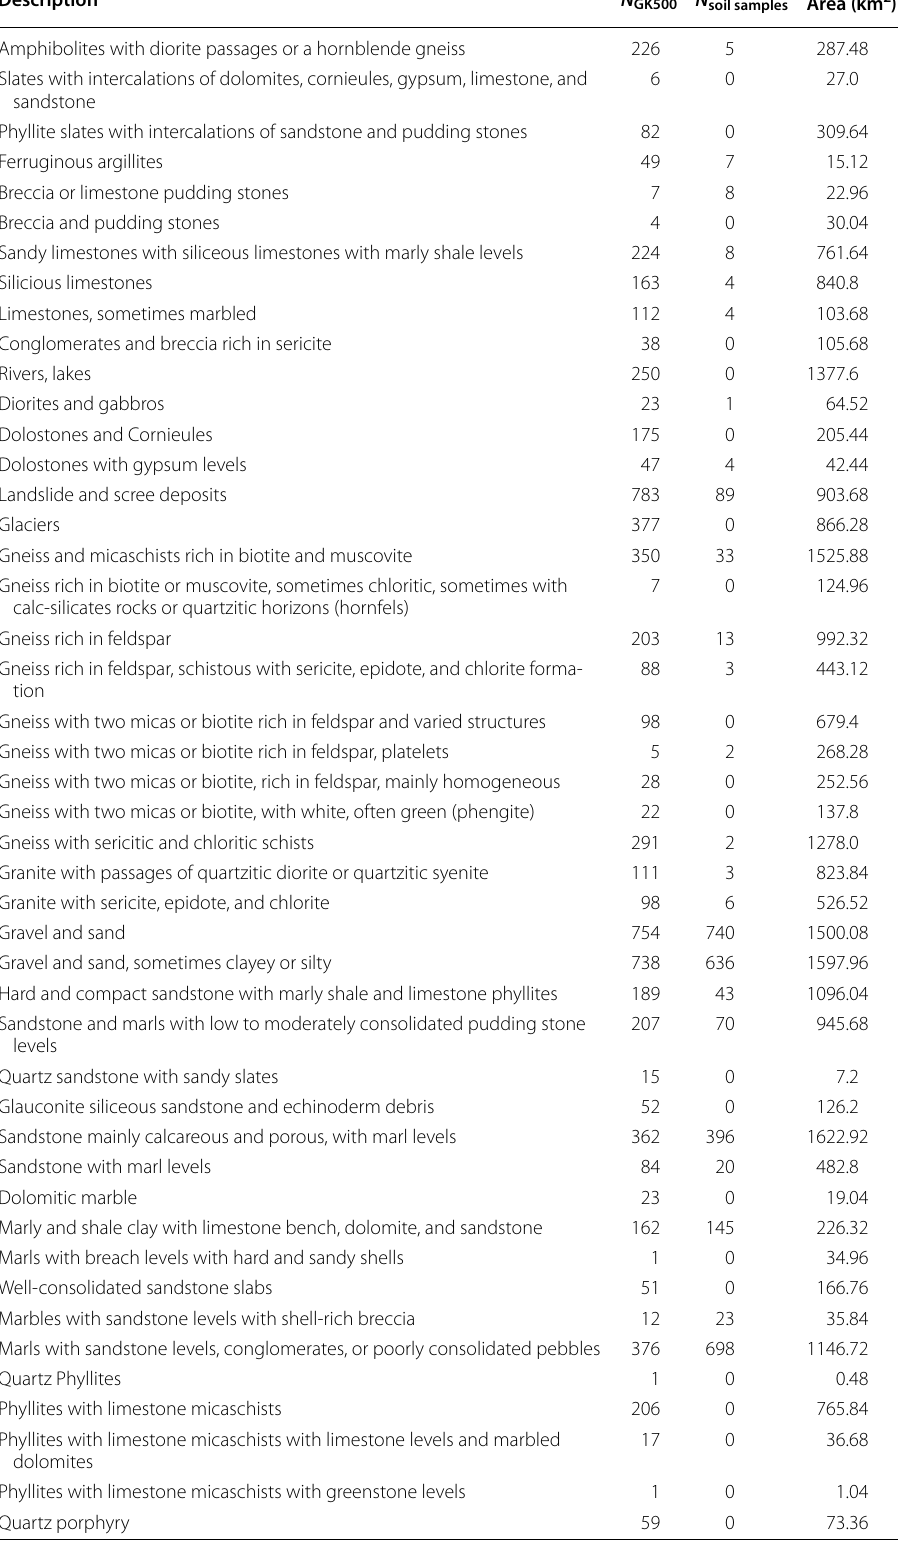
Table 8 Rock/soil types [LITH PET] categories in GK500 dataset